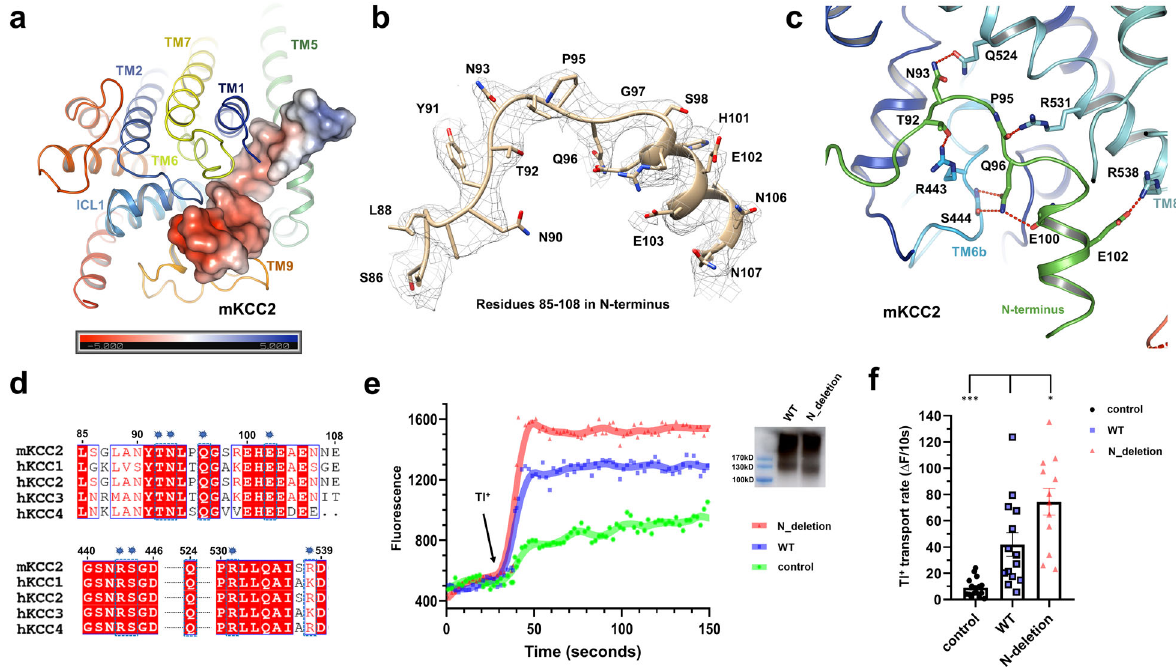
Fig. 2 Inhibitory N-terminus peptide in mKCC2. a An N-terminus peptide fragment blocks the entrance to the translocation pore of mKCC2. The peptide is shown as the electrostatic surface potential from -5 to + 5 kT/ e . b Density map of the representative residues 85 – 108 in N terminus of mKCC2 showing the 10.0 σ contour. Representative atomic model (gold) with side chains was fi tted into the cryo-EM density map (gray mesh). c Interactions between the N-terminus peptide and TM domains of mKCC2. T92, Q96, N93, P95, and E102 from the N-terminus peptide interact with R443 and S444 from TM6b, and interact with Q524, R531, and R538 from TM8 in mKCC2. d Sequence alignment KCCs in the regions of interaction between the N terminus, and of TMs 6 and 8. Numbering is that of mKCC2b. Interacting residues are highlighted by blue labels. e Fluorescence signal measurement of the cells transfected by control (mock virus), WT, and N-deletion (residue 85 – 120 deleted) mKCC2 virus. Transport activity was initiated by the addition of Tl + (arrow). The inset western-blot shows an expression of WT and N-(85 – 120) deleted mKCC2. f Relative Tl + transport rate in control ( n = 17), WT ( n = 14), and N-deletion ( n = 12) mKCC2. Unpaired Student ’ s t -test was used to evaluate the signi fi cance between WT and N-deletion mKCC2 (* P < 0.05), and between WT and control (*** P < 0.001); mean ±